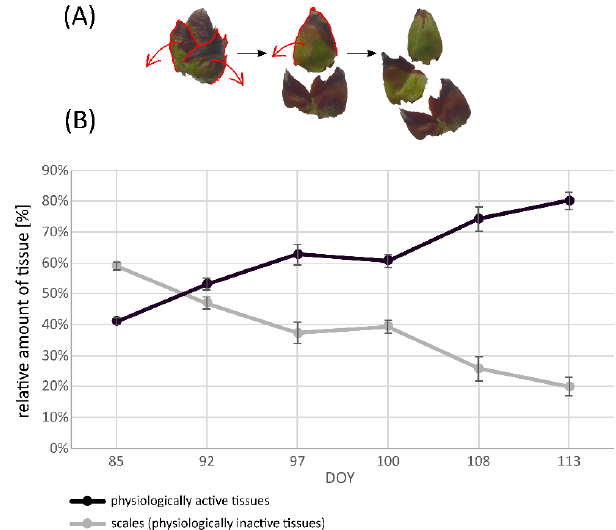
Figure 7. Process of descaling apple leaf buds ( A ) and relative amount [%] of bud scales and physiologically active tissues of apple leaf buds on each sampling date, expressed as day of the year [DOY] ( B ). Data points are shown as mean values ± standard deviation (n = 5).